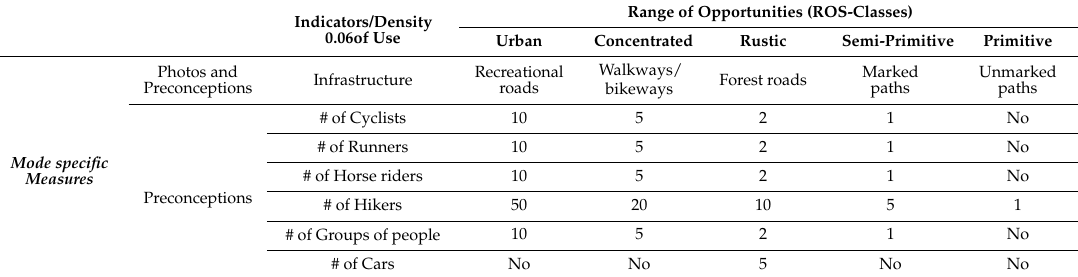
Table 2. Mode-specific standards of quality for 15 photos and 35 preconceptions used in our study (see Table A1). There are three photos within each ROS class. Preconceptions concern varying numbers of different recreationalists in each ROS class. For details regarding questions used in the survey, see text and Table